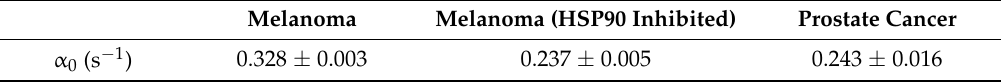
Table 5. Calibrated parameters for the tumor growth model.